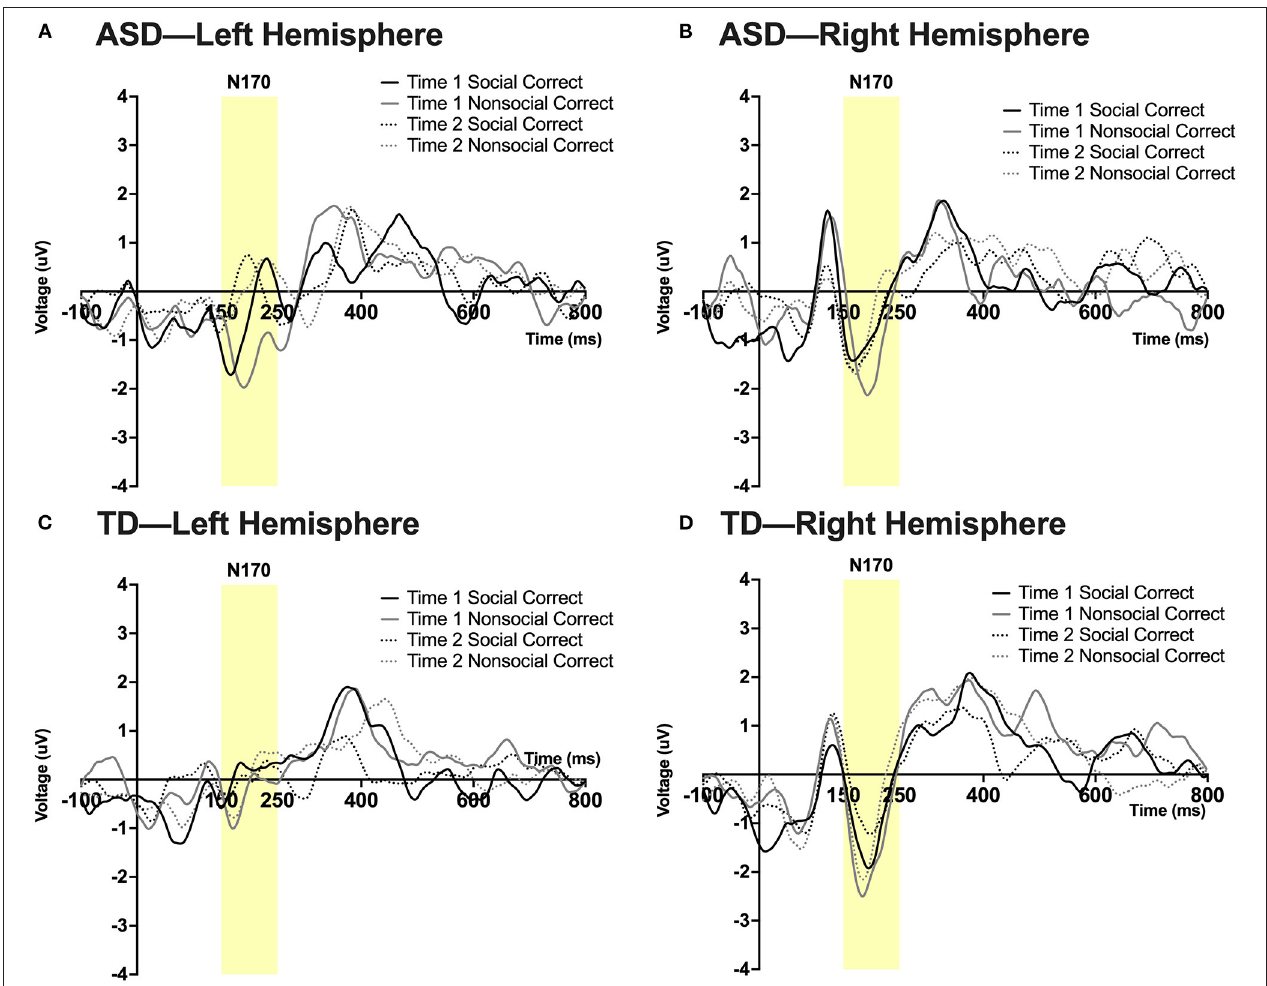
FIGURE 5 | Grand average waveforms in the social and non-social conditions at Time 1 and Time 2 for the N170 ERP in (A) ASD participants in the left hemisphere, (B) ASD participants in the right hemisphere, (C) TD participants in the left hemisphere, and (D) TD participants in the right hemisphere. Note that for this figure, ERPs were filtered using a 25Hz low-pass